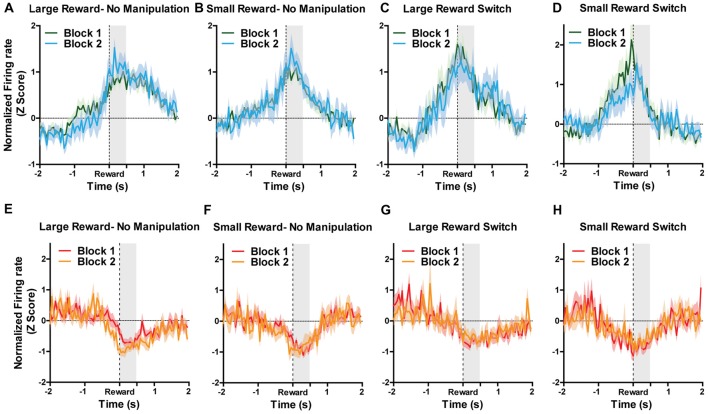
For all figures, the Y axis represents the normalized firing rate during a 4 s window centered on reward encounters. X axis represents time. Block 1 are the first five trials during which sizes of rewards were always located as expected. During Block 2, rewards could remain in their expected location (no manipulation) or could be switch (reward switch condition). For “large reward switch,” during Block 2, rats received a large reward when they were expecting a small reward. For “small reward switch,” during Block 2, rats received a small reward when they were expecting a small reward. A two-way ANOVA for manipulation type (none or reward switch) and Block (1 and 2) were performed separately for small and large rewards on the normalized firing rates during the first 500 ms after reward encounters (shaded region). Graphs represent normalized responses of (A) Reward excited neurons to large rewards when there was no manipulation in Block 2. (B) Reward excited neurons to small rewards when there was no manipulation in Block 2. (C) Reward excited neurons to large rewards when reward locations were switched in Block 2. (D) reward excited neurons to small rewards when reward locations were switched in Block 2. (E) Reward inhibited neurons to large rewards when there was no manipulation in Block 2. (F) Reward inhibited neurons to small rewards when there was no manipulation in Block 2. (G) N reward inhibited neurons to large rewards when reward locations were switched in Block 2. (H) Reward inhibited neurons to small rewards when reward locations were switched in Block 2. Block order and manipulation did not significantly affect firing rates during reward encounters for small or large rewards for either reward excited or reward inhibited neurons (all p’s > 0.05; see “Results” section).